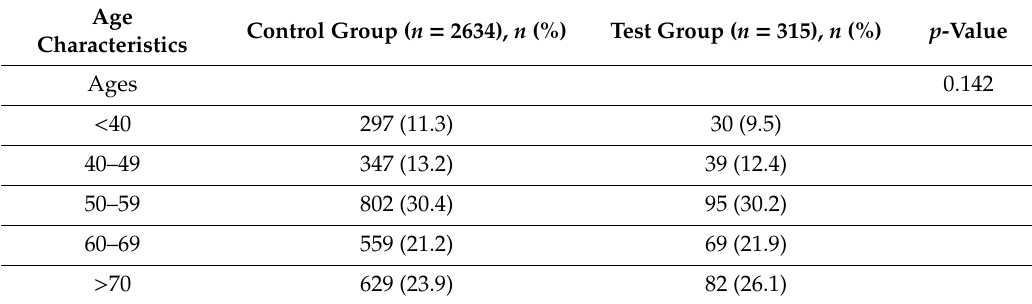
Table 3. Comparison of demographic characteristics age (t-test).